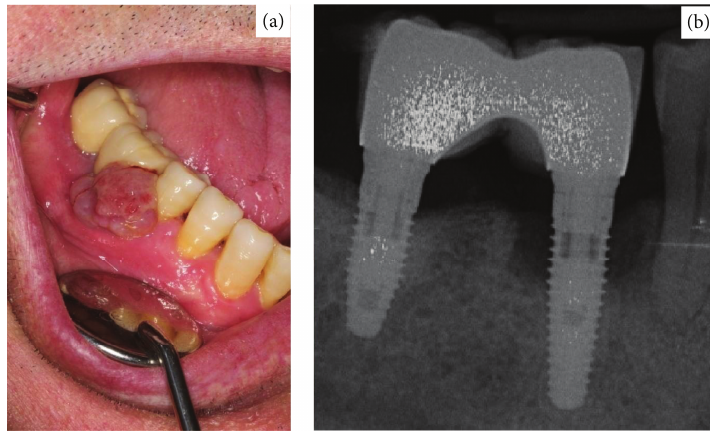
Figure 4: (a) Exophytic granulomatous lesion in 4.6. (b) Periapical radiograph that shows bone involvement in implant 46.